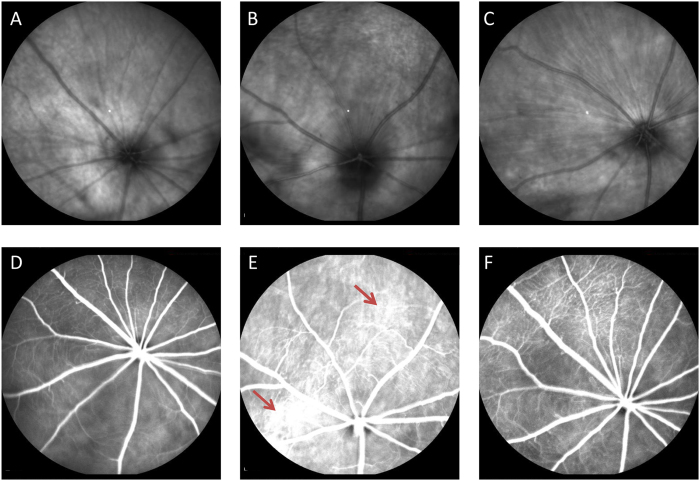
Fundus examination and fluorescein angiography in rat eyes.(A,D) Group N rat retinal fundus showing fine networks of blood vessels; (B,E) Group A rat fundus showing thin and irregular vascular networks with intensive light-reflection; (C,F) Group L rat showing improved morphology of retinal vascular network.